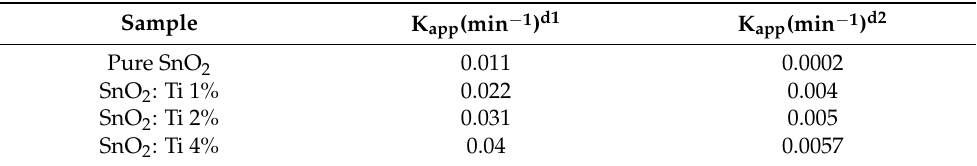
Table 3. Apparent constant rates (Kapp) for the degradation of RhB for Ti–SnO 2 NPs under UV and Visible light